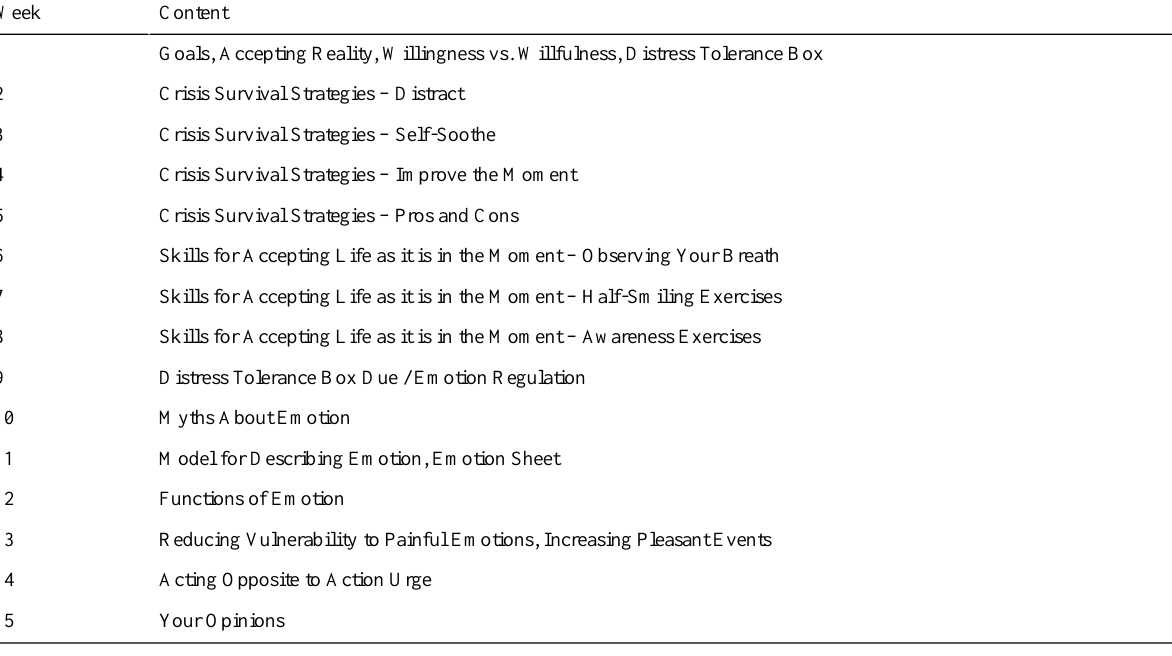
Table 1. Managing Powerful Emotions sessions. ContentWeek